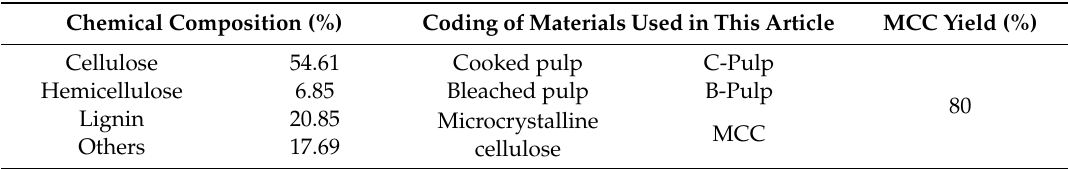
Table 1. Chemical composition of used bamboo fibers used and terminologies used for the intermediate and final materials